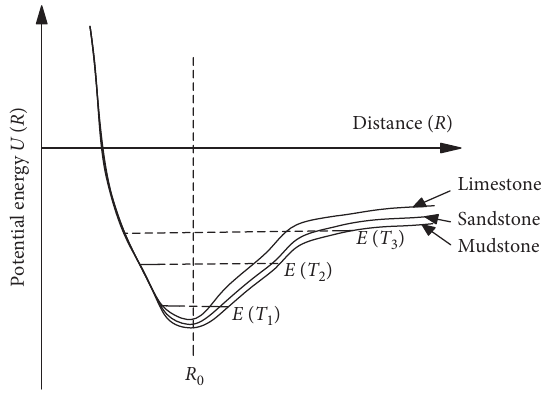
Figure 8: Potential energy of two interacting atoms in the thermal expansion of mudstone, sandstone, and limestone (modified after [40]).